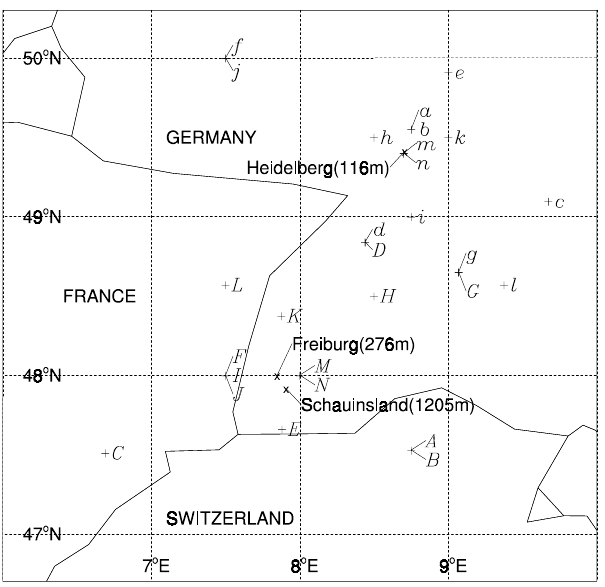
Fig. 1. Locations of Freiburg, Heidelberg and Schauinsland mea- surements along with the sampling locations of each model (let- ters). Capital letters are the model locations representing Freiburg and Schauinsland, lower case letters represent Heidelberg. See Ta- ble 1 to identify the model corresponding to each